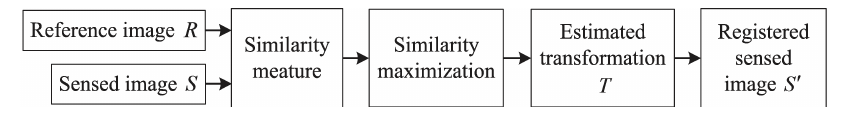
Figure 3. Flow chart of dense